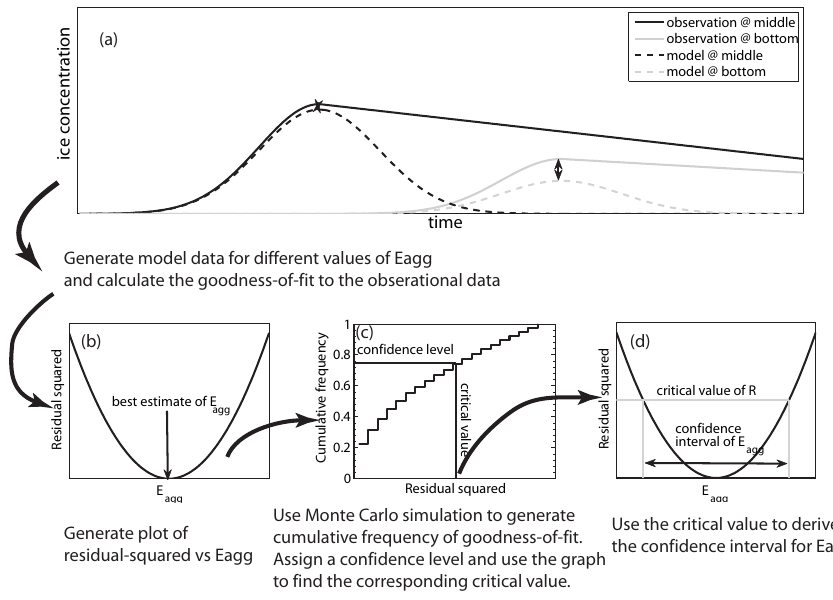
bar is assigned (25 %) to find the critical value of the goodness-of-fit above which the observation and model are significantly different. Remapping this to the graph of goodness-of-fit vs. E agg gives